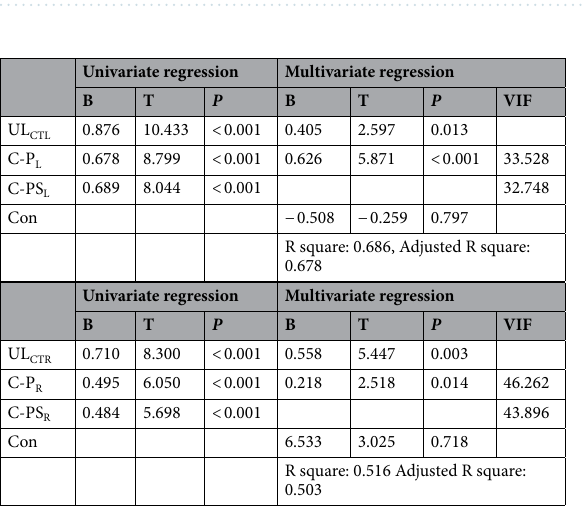
Table 3. The results of regression and validation analyses. The subscript L and R is represented with left side and right side, respectively. C-P and C-PS, length measured in KUB radiography. UL CT , length measured in axial CT. Con is the constant of